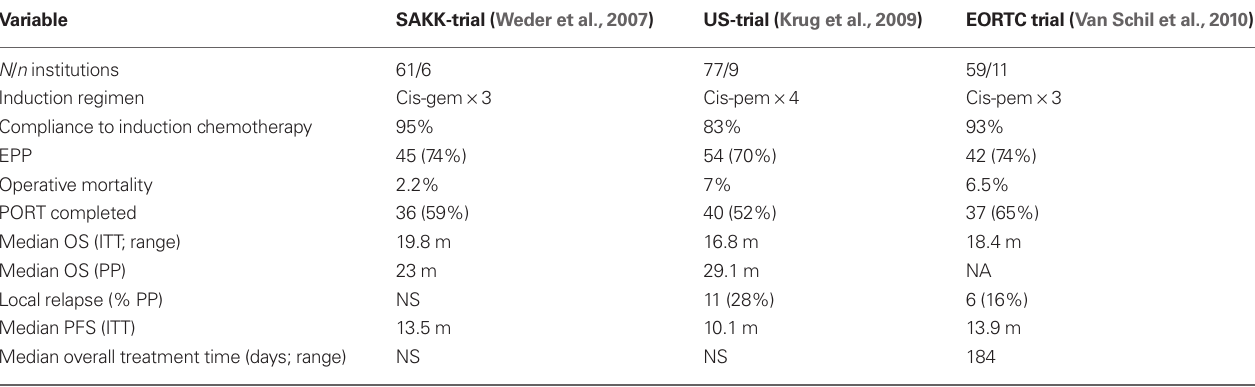
Table 1 | Prospective multicentre phase II trials of radical multimodality treatment in early stage mesothelioma.